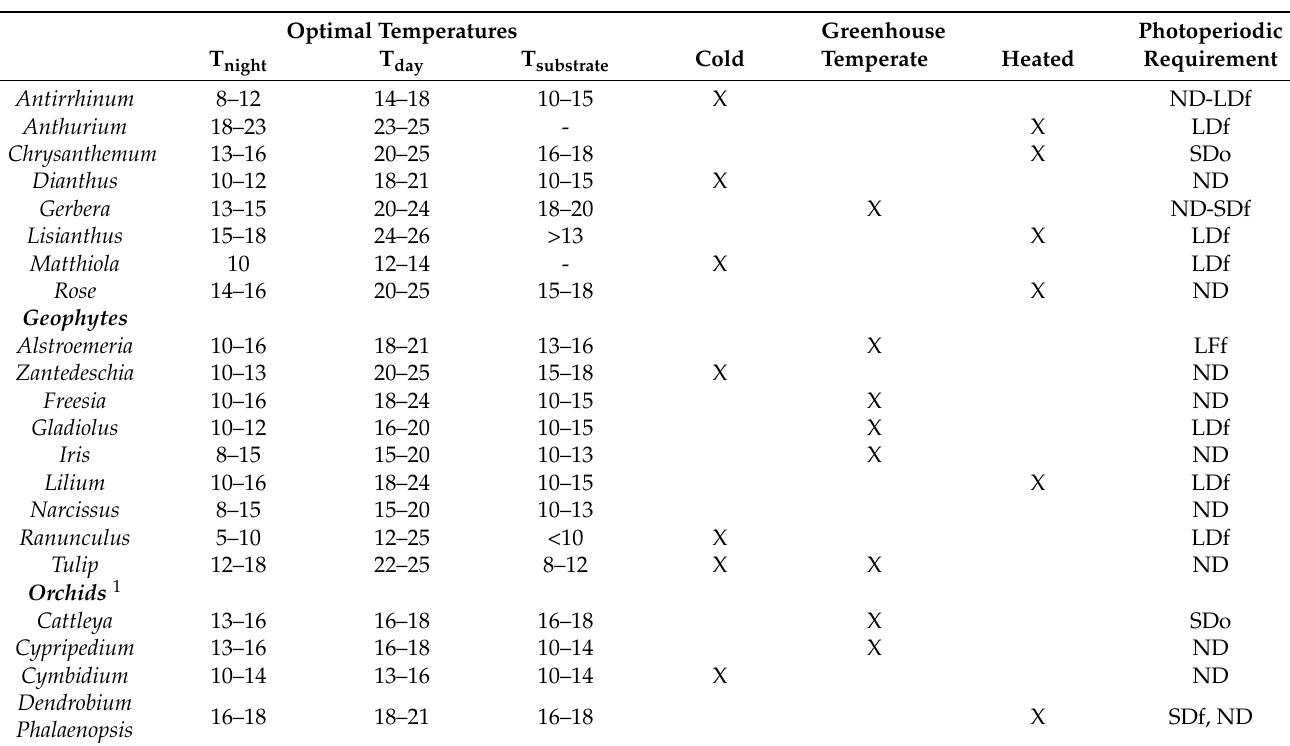
Table 1. Optimal temperatures, suitability for different air conditioning levels in greenhouses (based on minimum night temperature, T night ), and photoperiodic requirement for flowering in the main cut-flower